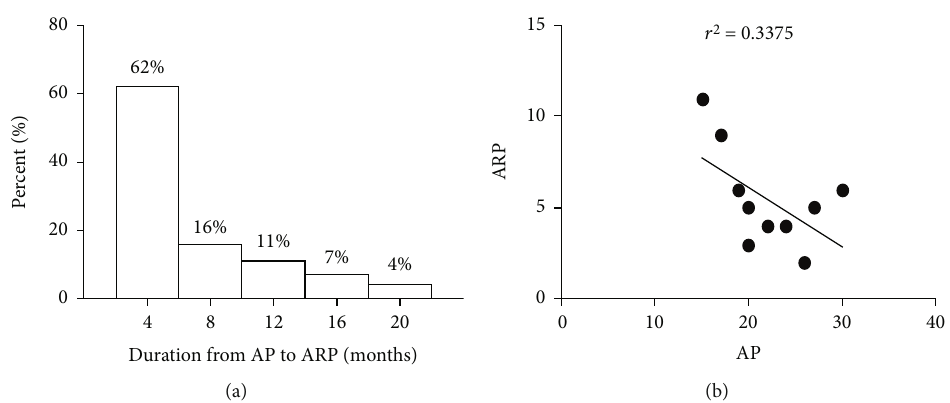
Figure 1: (a) Time to recurrence of pancreatitis from the fi rst episode of AP to second AP. (b) The linear regression analysis on the number of people with AP and ARP every